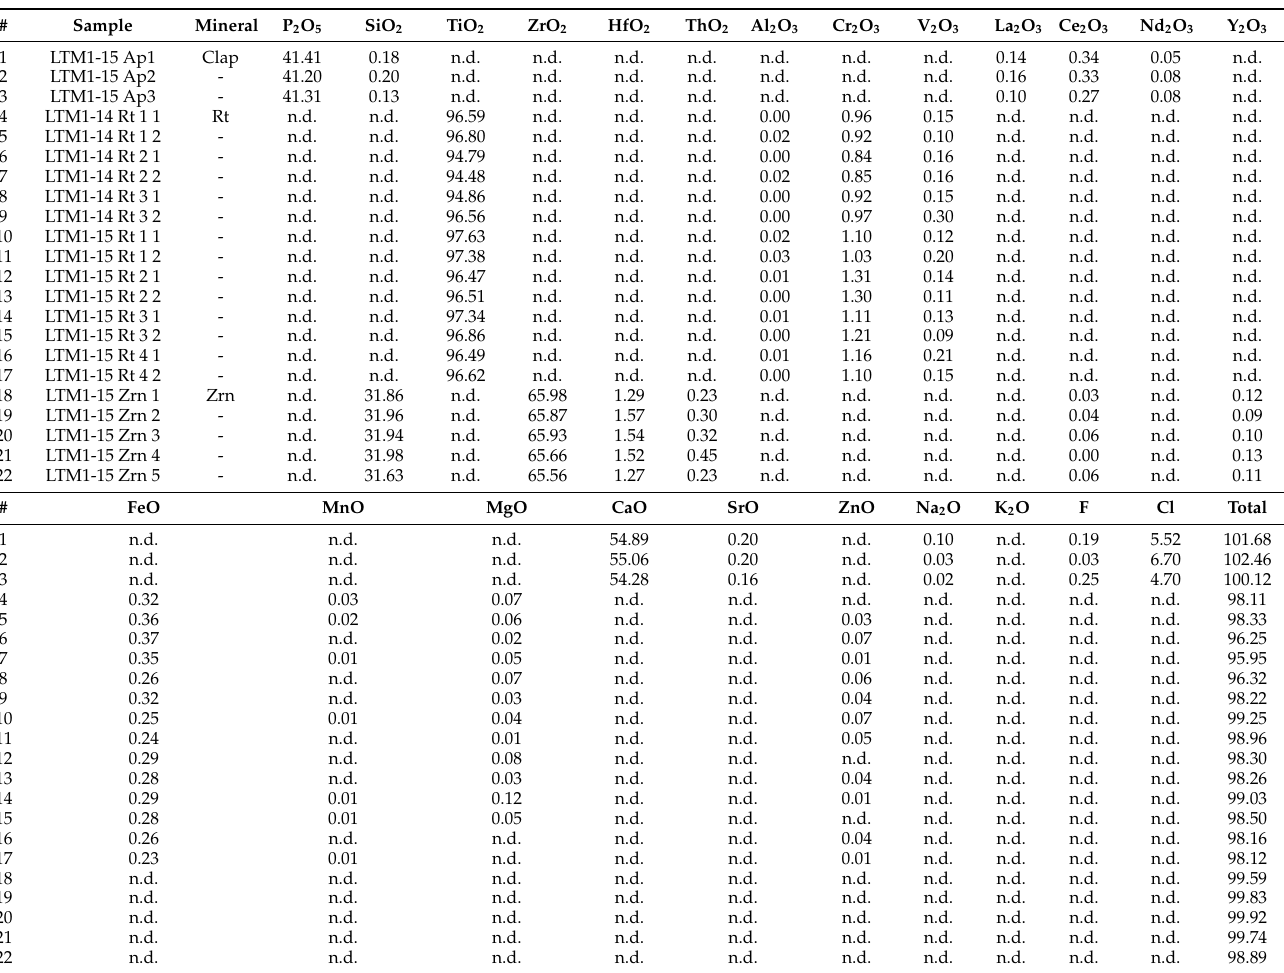
Table 8. Compositions of accessory grains of chlorapatite, rutile and zircon in the orthopyroxenite zone of the Lotmvara-I sill, Kola